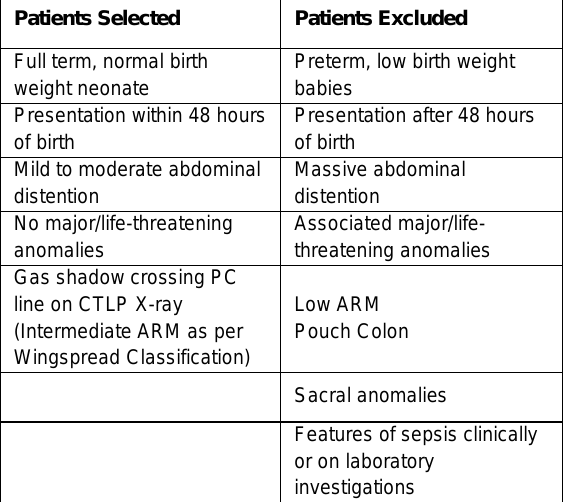
Figure 1: Cross-table lateral prone X-ray of a male neonate suggesting an intermediate variety of Anorectal Malformation. Table 1: Case Selection Criteria for selecting male neonates for primary